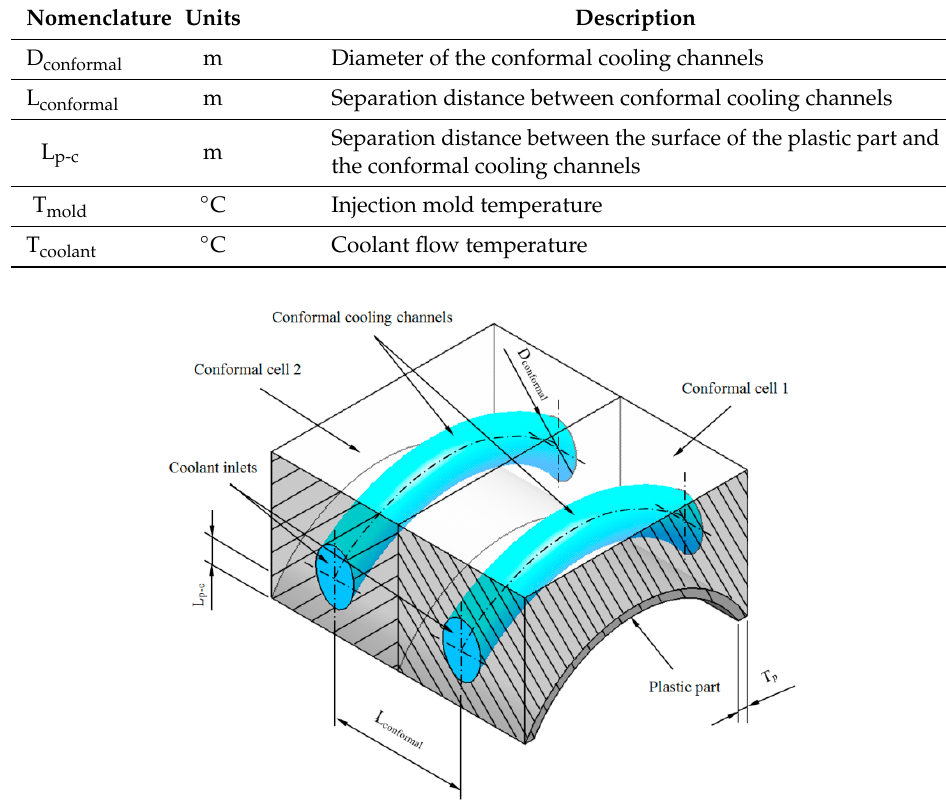
Figure A1. Cooling cells considered for the dimensioning of the cooling system variables.